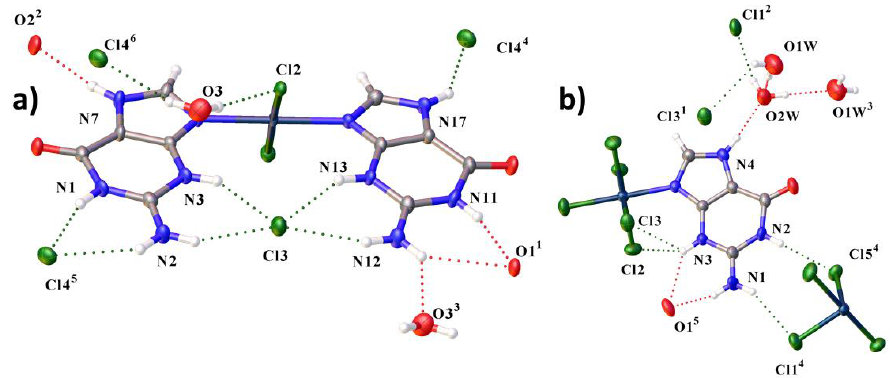
Figure 2. View showing hydrogen bonds in 1 ( a ) and in 2 ( b ). Symmetrical molecules of the complex are not shown in full for clarity.